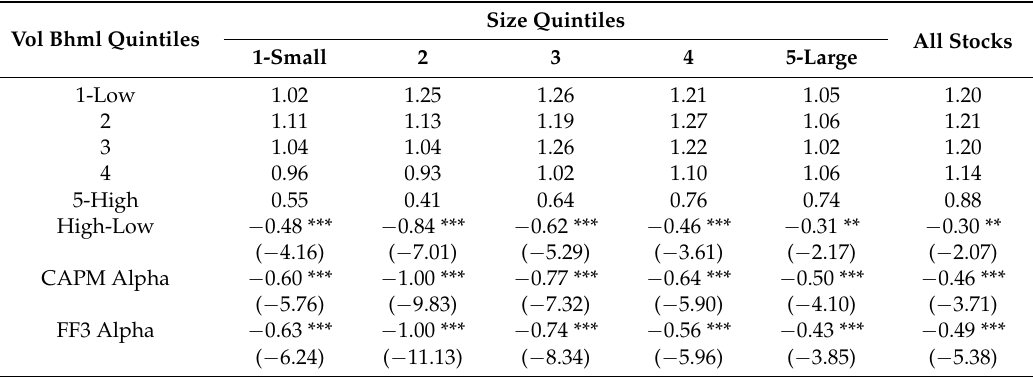
Table 5. Sort by size and